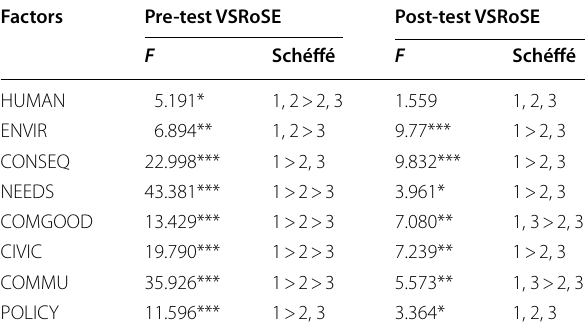
Table 5 MANOVA by group and post hoc